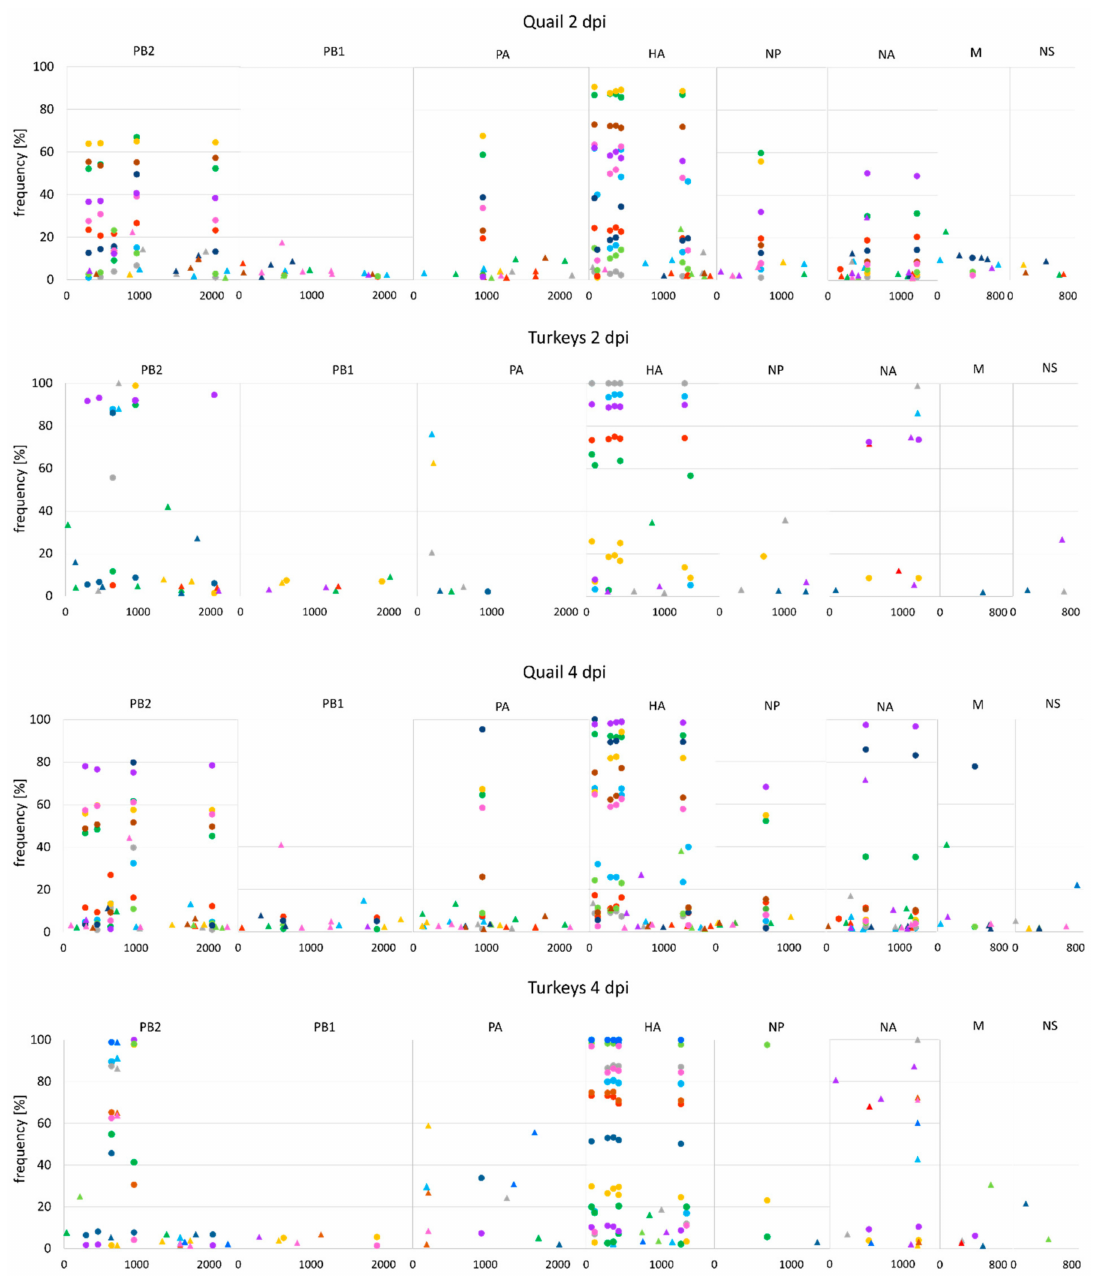
Figure 4. Distribution and frequency of variants in the virus population in oropharyngeal swabs collected from turkeys and quail infected with H9N2 AIV. The x-axis represents the genomic positions for each genome segment. Variants present in the same samples are showed with the same colour. Circles – variants of inoculum origin, triangles – variants that emerged during